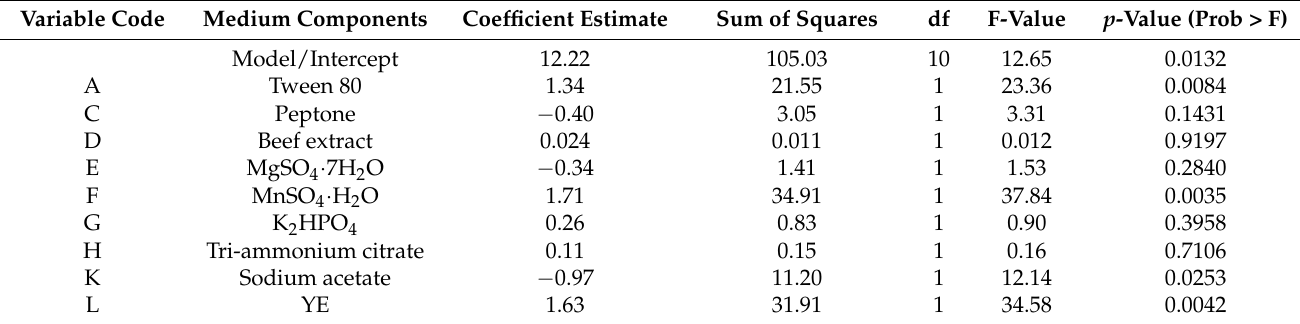
Table 3. The analysis of variance (ANOVA) from the PBD experimental